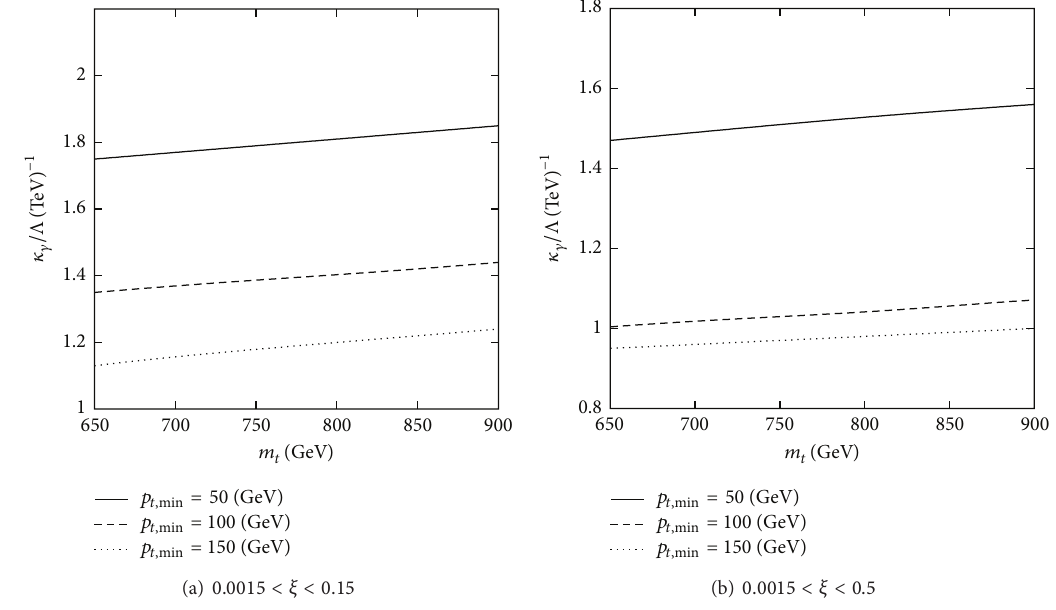
Figure 3: The parameter plane of 𝑚 𝑡 󸀠 and 𝜅 𝛾 /Λ for the two different acceptances: 0.0015 < 𝜉 < 0.15 and 0.0015 < 𝜉 < 0.5 at 95 % CL using 𝜒 2